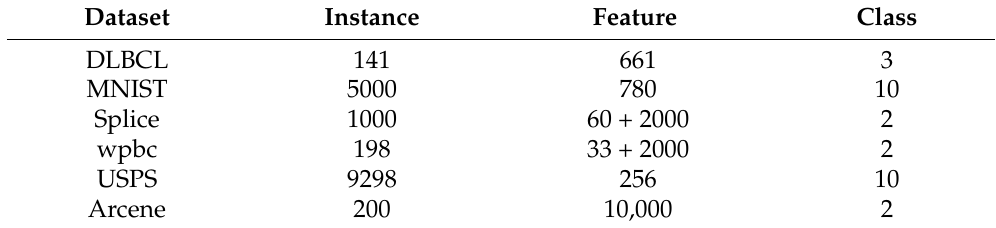
Table 4. Summary of data sets